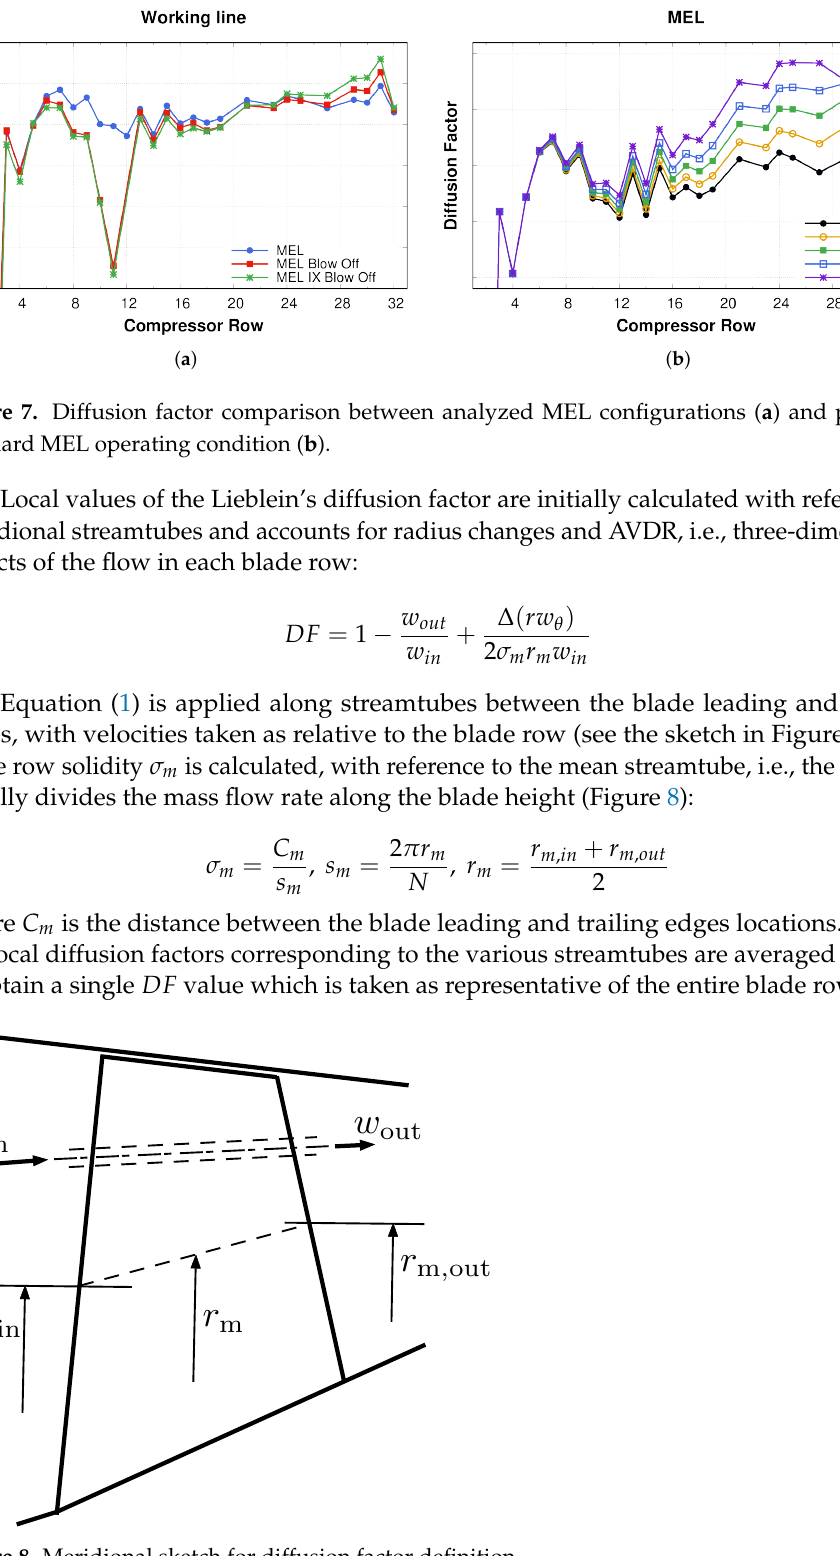
Figure 8. Meridional sketch for diffusion factor